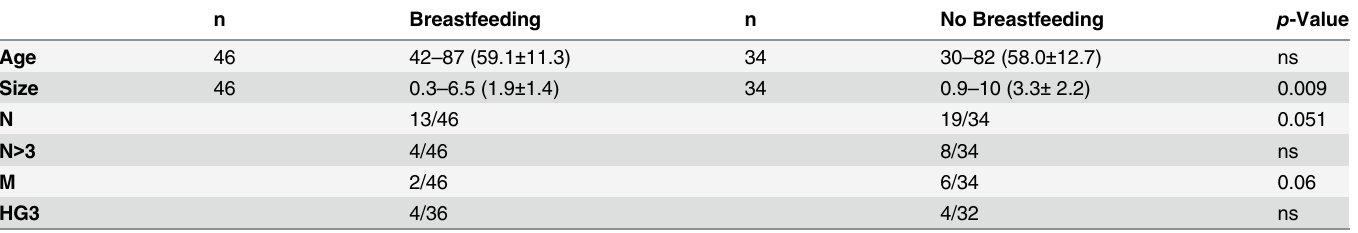
Table 1. Relationship between breastfeeding and clinicopathological parameters in patients with infiltrating lobular breast carcinoma (ILC). A p- value of 0.05 was considered to be significant.